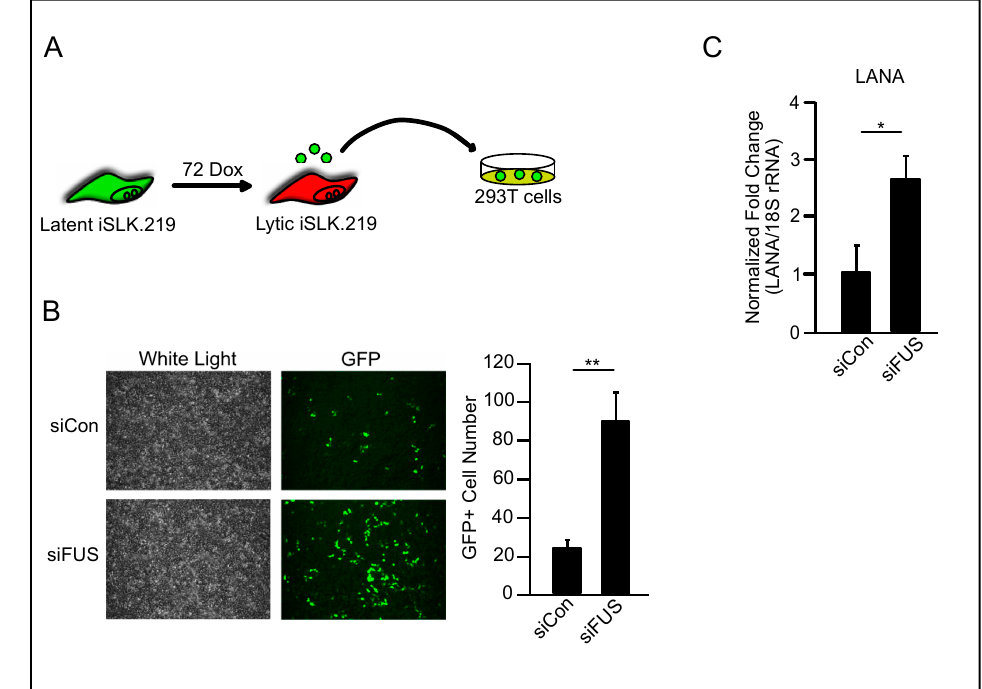
Figure 4. FUS restricts KSHV virion production in iSLK.219 cells. ( A ) Schematic of supernatant transfer. ( B ) Fluorescent microscopy, at 10× magnification, of KSHV-infected HEK293T cells following supernatant transfer from FUS-depleted iSLK.219. GFP-positive cells were infected with the virus. Quantification of GFP-positive cells is to the right. Values represent four independent views of the infected cells. ( C ) LANA mRNA levels from HEK293T cells in ( B ). Student t test used to determine statistical significance * p ≤ 0.05. ** p ≤ 0.005.